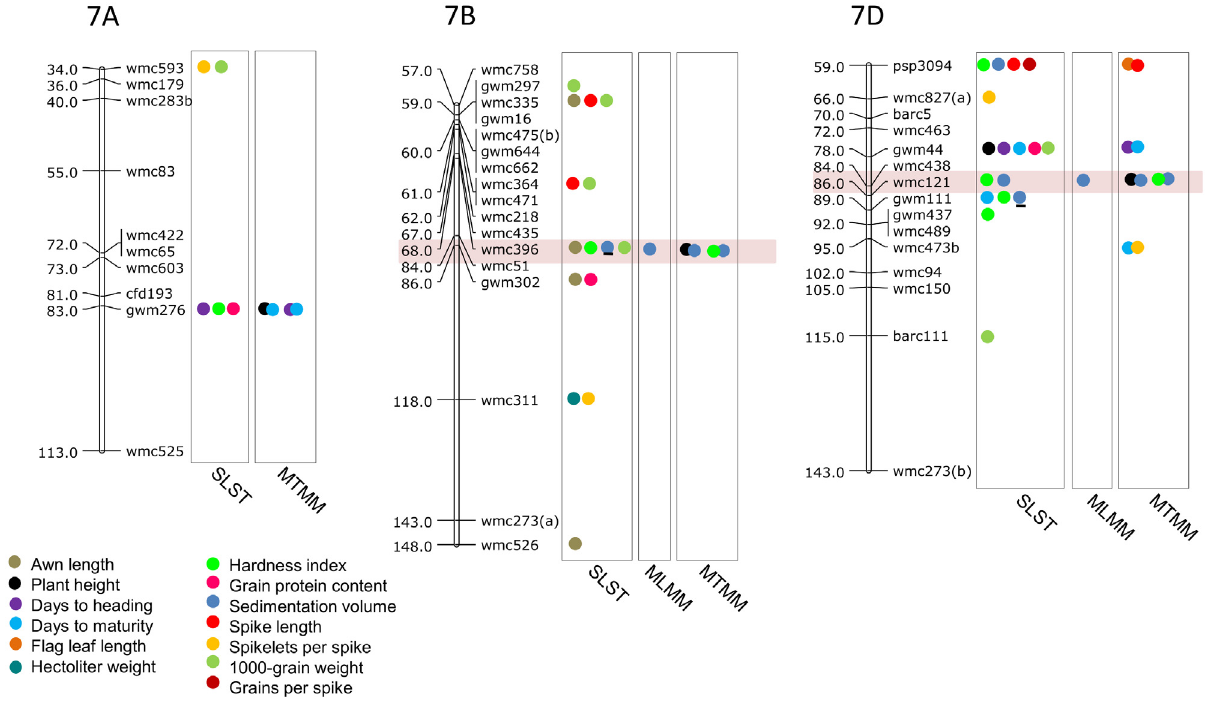
Fig 9. SSR genetic linkage maps of homoeologous group 7 chromosomes showing markers-trait associations (markers associated with different traits are shown by solid circles with different colours), black bar given below the solid circle represents that MTA qualified FDR criterion; markers are indicated to the right and map distances (cM) are indicated to the left of the vertical bar (based on the consensus linkage map of Somers et al. [76]). MTAs identified through all three approaches (SLST, MLMM and MTMM) are highlighted with pink.